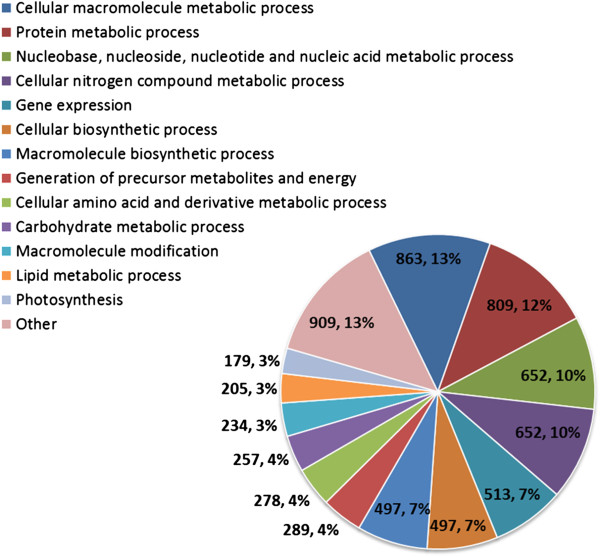
B. brauniiShowa contigs annotated with Gene Ontology terms for molecular function.